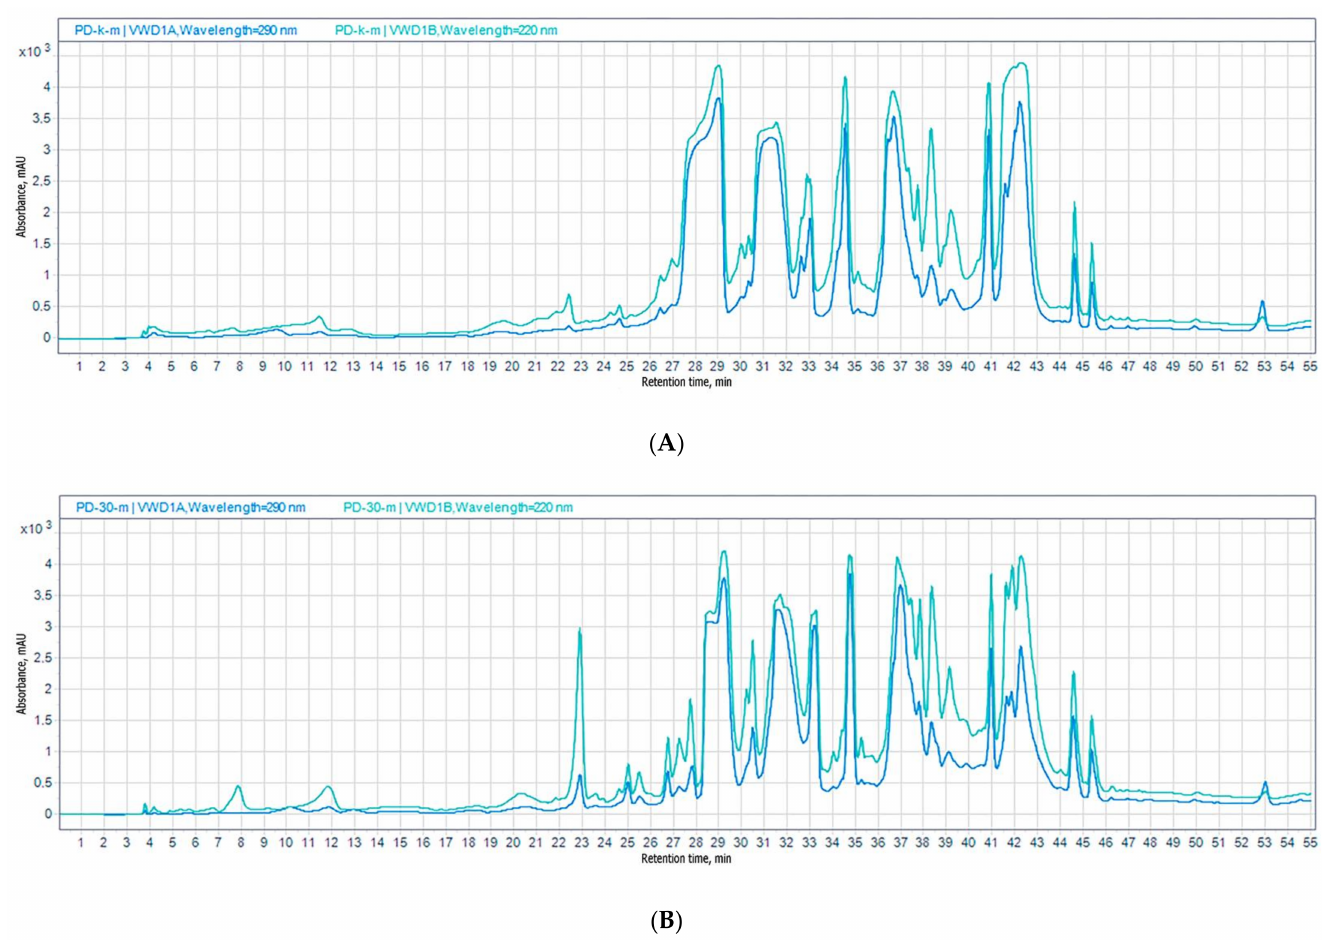
Figure 1. HPLC UV chromatograms of extracts from fungus cultivated with sea water at 22 ◦ C ( A ), and at 30 ◦ C ( B ). Chromatograms were recorded at 290 nm (blue) and 220 nm